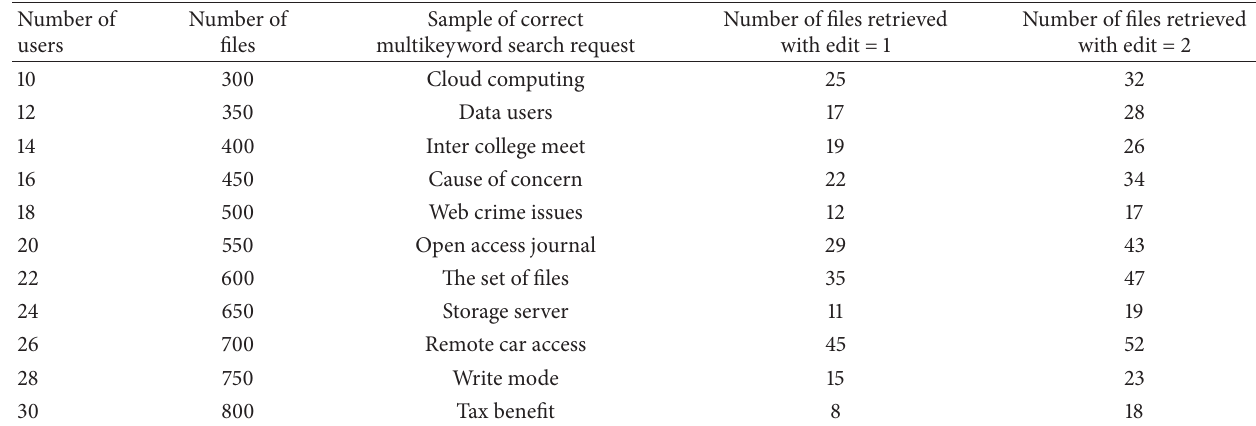
Table 2: Analysis of data utilization efficiency for correct keywords.